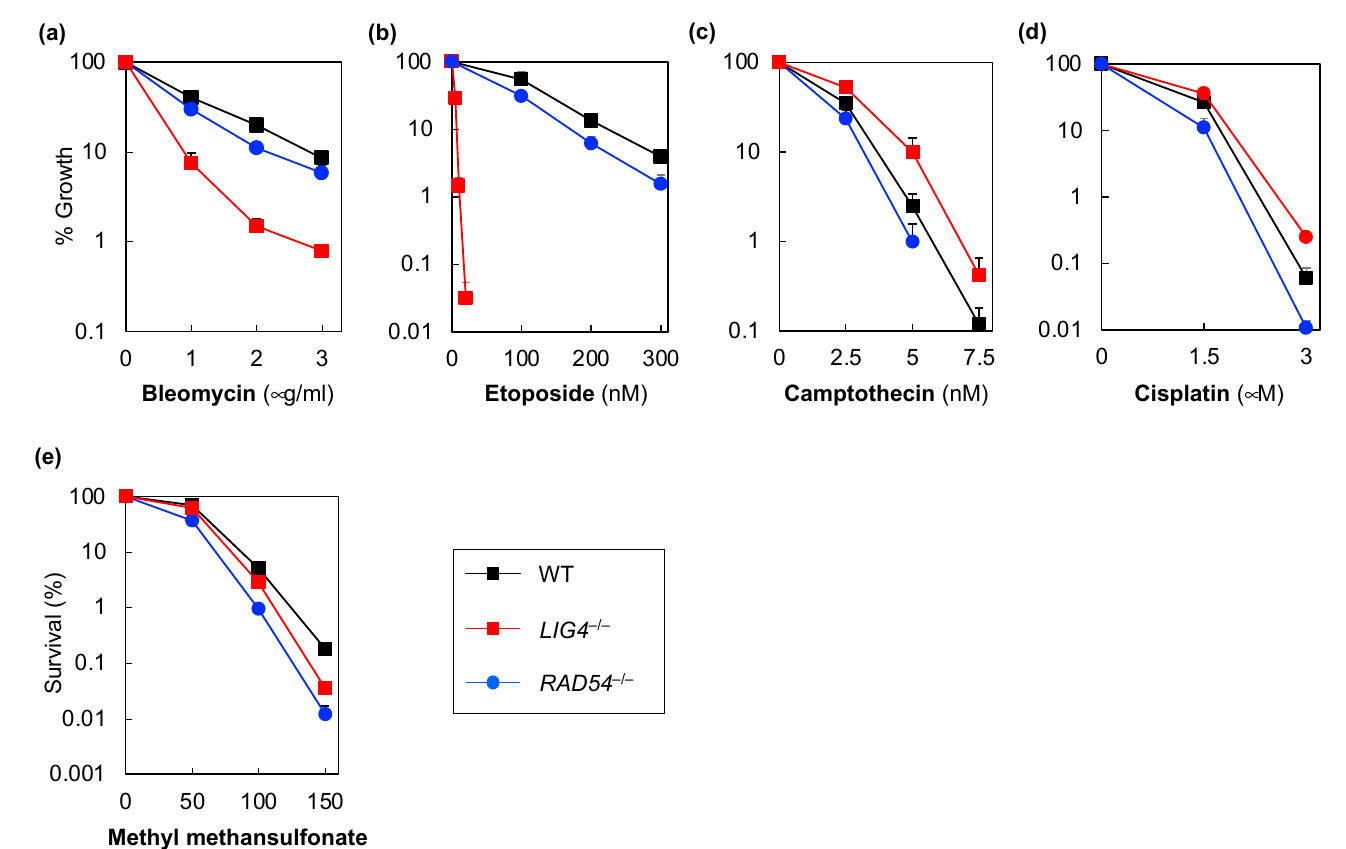
Figure 1. Sensitivity of human LIG4 − / − (non-homologous end-joining-deficient cells), RAD54 − / − (homologous recombination-deficient cells), and wild-type Nalm-6 cells to DNA damage agents. Sensitivities of human LIG4 − / − , RAD54 − / − , and wild-type Nalm-6 cells to bleomycin ( a ), etoposide ( b ), camptothecin ( c ), cisplatin ( d ), and methyl methanesulfonate ( e ) determined using a growth inhibition assay ( a – d ) or colony formation assay ( e ). Data represent the mean ± standard deviation of three independent experiments. Where absent, error bars fall within the symbols.